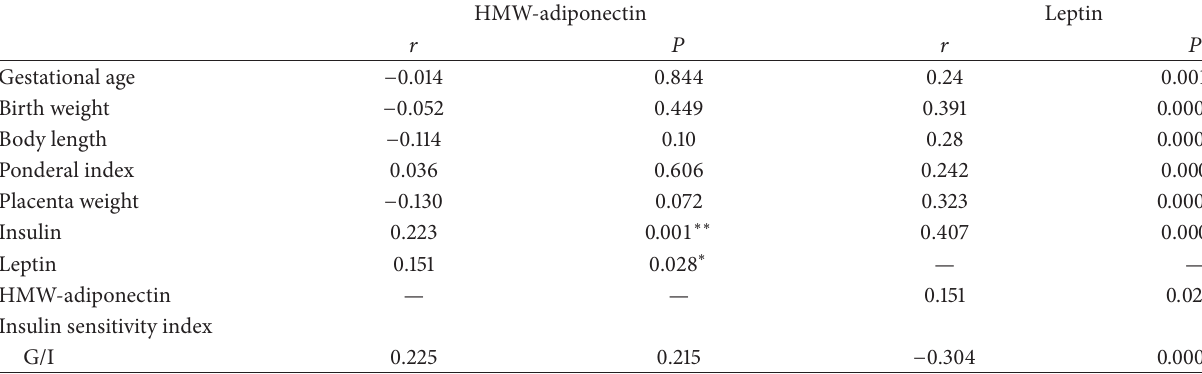
Table 3: Univariate correlation coefficients.